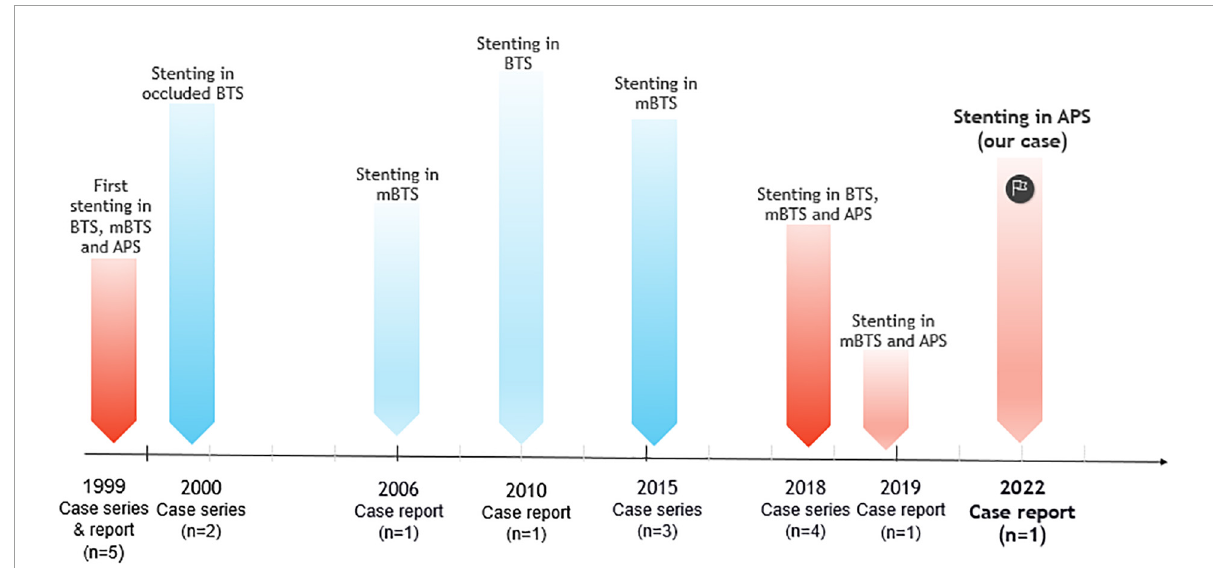
FIGURE1 Timeline of endovascular stent implantation in systemic-to-pulmonary arterial shunts (SPSs) including, classical Blalock–Taussig shunt (BTS), modified Blalock–Taussig shunt (mBTS), and central aorto-pulmonary shunt (APS) in adult patients ( ≥ 18 years old).